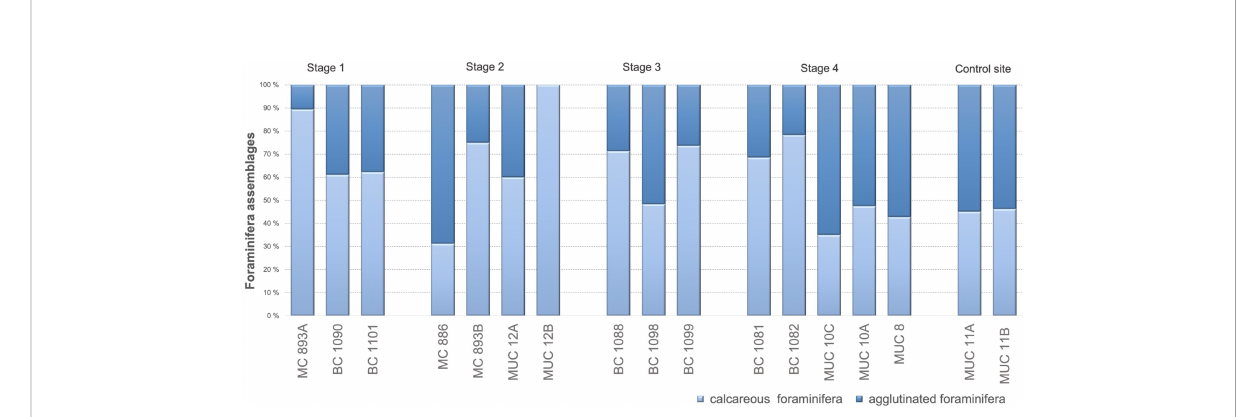
FIGURE 4 Percentage ratio between calcareous and agglutinated foraminifera for each Stage (S) of environmental succession; direct counting. S1: S2 p = 0.04; S1: S3 p = 0. 05; S1: S4 p = 0.05; S1: control site p = 0.00; S2: S3 p = 0.02; S2: S4 p = 0.06; S2: control site p = 0.00; S3: S4 p = 0.16; S3: control p = 0.01; S4: control site p =